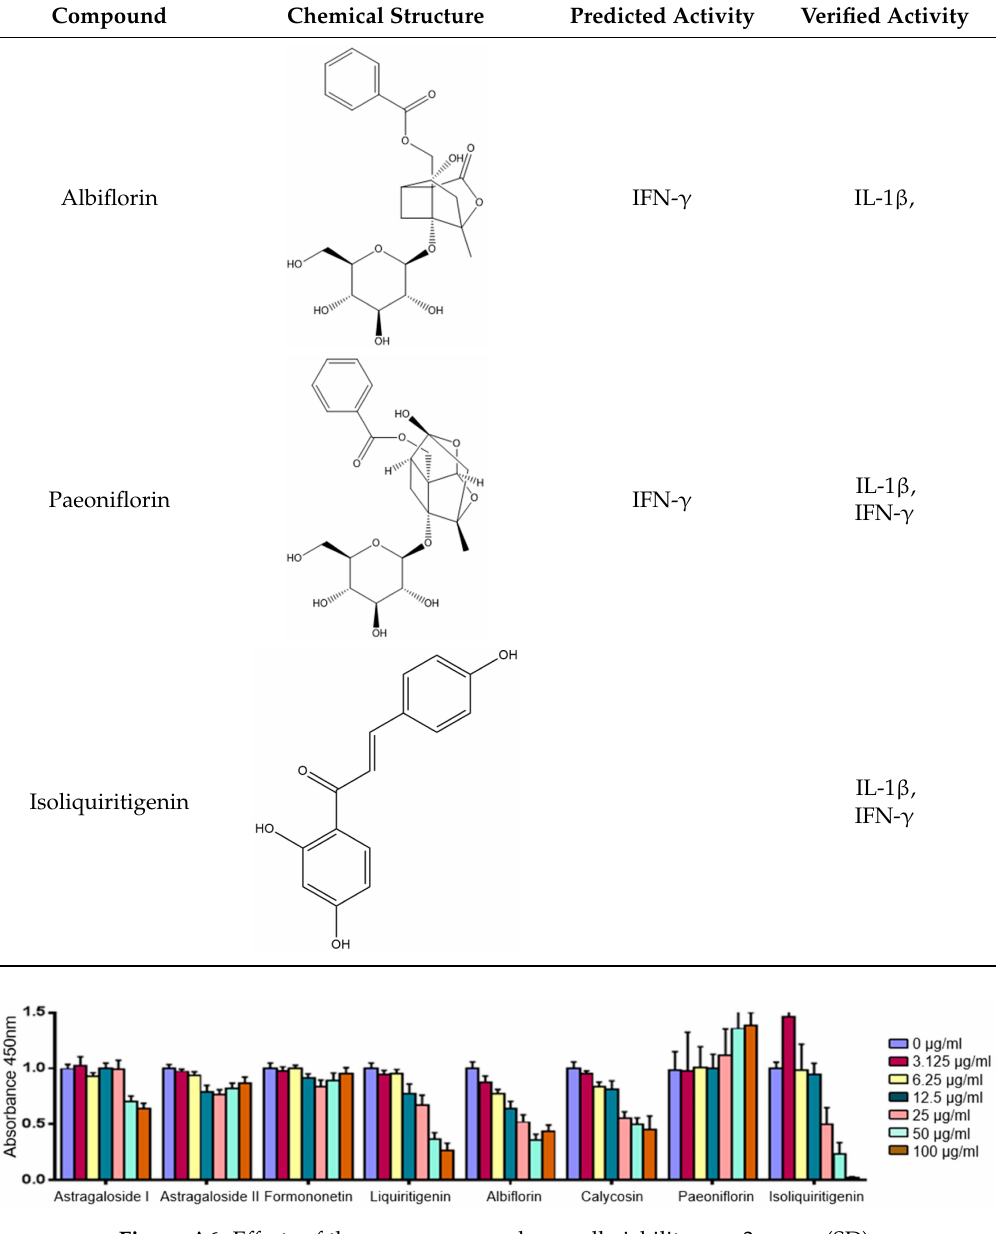
Figure A6. E ff ects of the pure compounds on cell viability; n = 3; mean